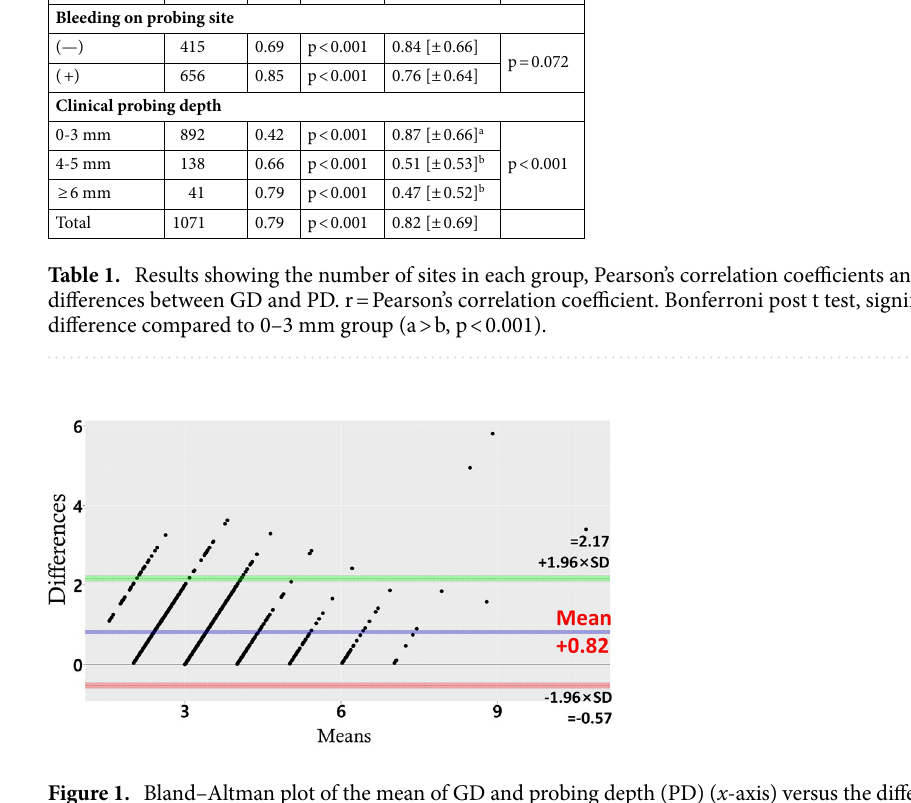
Figure 1. Bland–Altman plot of the mean of GD and probing depth (PD) ( x -axis) versus the difference between GD and PD ( y -axis). The mean difference (blue line) between GD and PD was 0.82 mm. The limits of agreement (green and red lines) are defined as the mean difference plus and minus 1.96 × the standard deviation. The coordinates never cross below 0 mm, because GD is always larger than or equal to PD. Since the lower limit is 0 mm, the two measurement methods had limits of agreement between 2.17 and 0